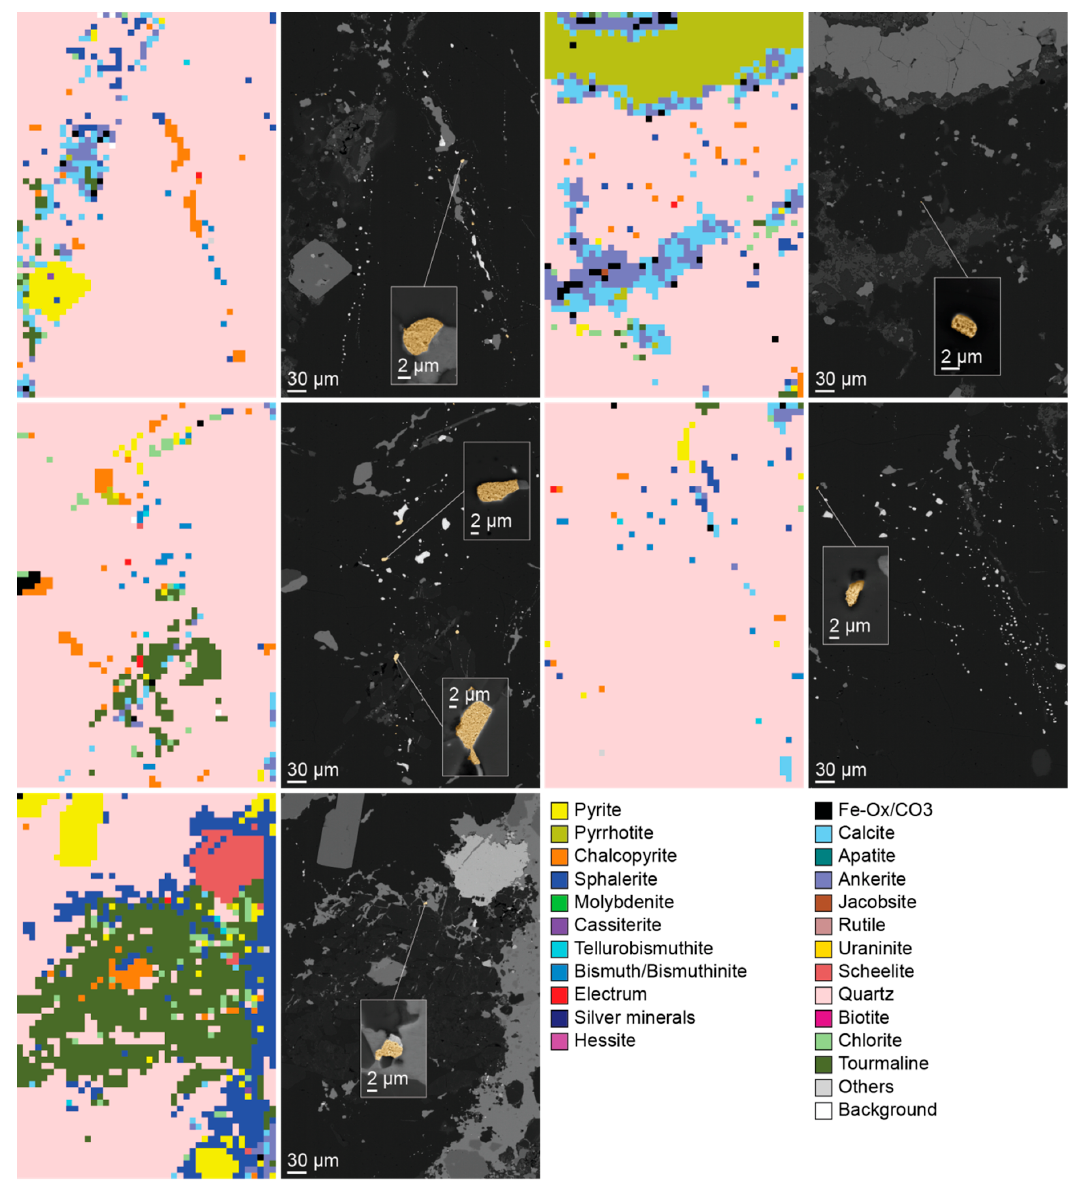
Figure 6. Areas of the QEMSCAN ® mineral map by CSM (left) containing pixels identified as electrum (red) and corresponding backscattered electron images of the same areas by FEG-SEM (right). Gold grains detected by CSM and Boliden AB (after reprocessing) are false-colored in the BSE images. The Au grains detected by the CSM scan are also magnified. The magnified images are secondary electron images recorded by FEG-SEM.